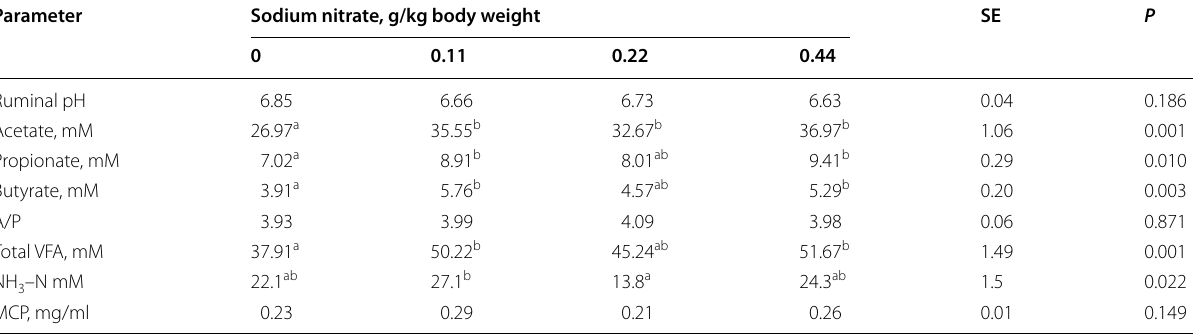
Different letters in the same row means significant differences ( P < 0.05)